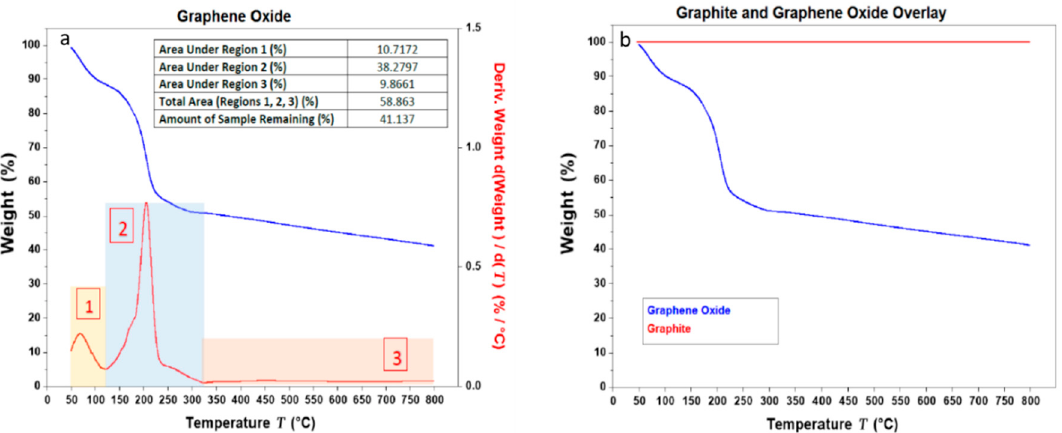
Figure 3. ( a ) TGA (Thermogravimetric analysis) (in blue) and DTGA (derivative) (in red) thermograms for GO. The area under the different segments (area 1, area 2 and area 3) of the graph and the total area under the graph are indicated as % in the table (see inset of image ( a ). ( b ) Shows an overlay of the TGA results for graphite and GO.